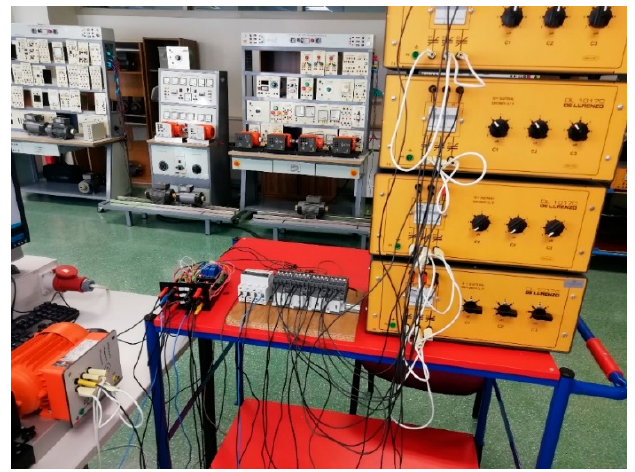
Figure 9. Difference between PF OBT and power factor desired (PF DES ).